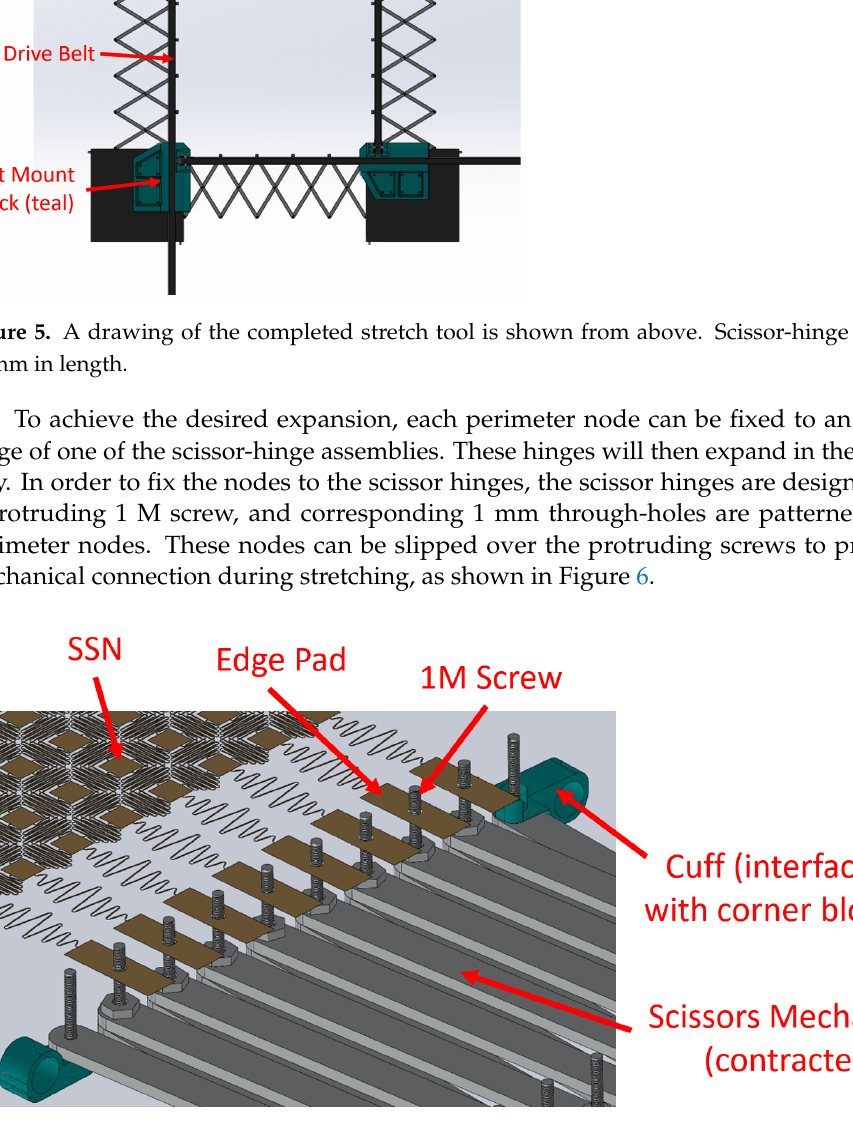
Figure 6. The interface between the scissor-hinge and the perimeter nodes is shown. Note the 1 M screws protruding through the through-holes in the edge